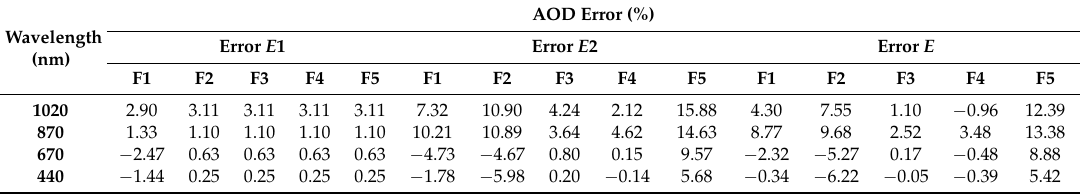
Figure 4. Error of AOD retrieved at 1020 nm, 870 nm, 670 nm and 440 nm between the experimental instruments and the reference instrument under the condition of the instruments’ status being “non-affected”. Table 2. Error of the aerosol optical depth (AOD) retrieved at 1020 nm, 870 nm, 670 nm and 440 nm between the experimental instruments and the reference instrument.